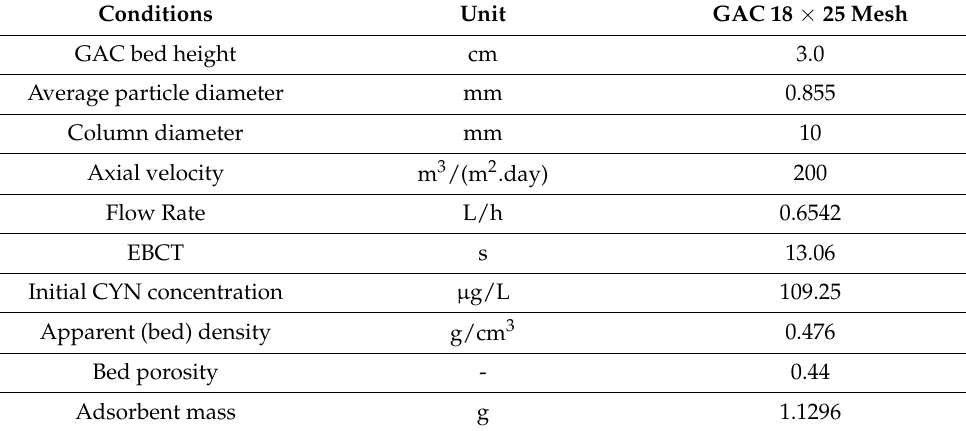
Table 1. SBA operating